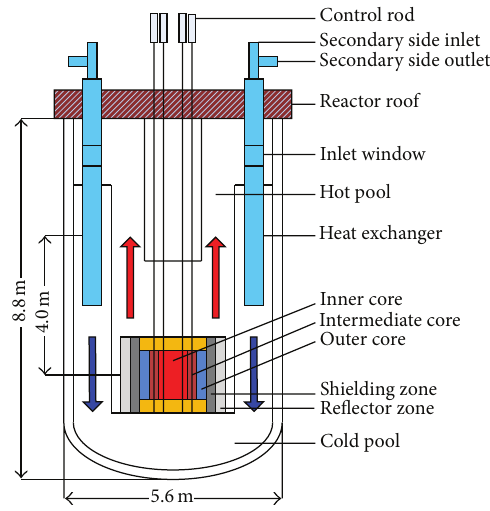
Figure 1: SNRLFR-100 vertical section